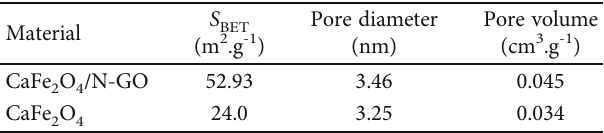
0.0 Figure 5: N adsorption-desorption isotherm of the synthesized 2 Table 1: The determined surface area, pore diameter, and